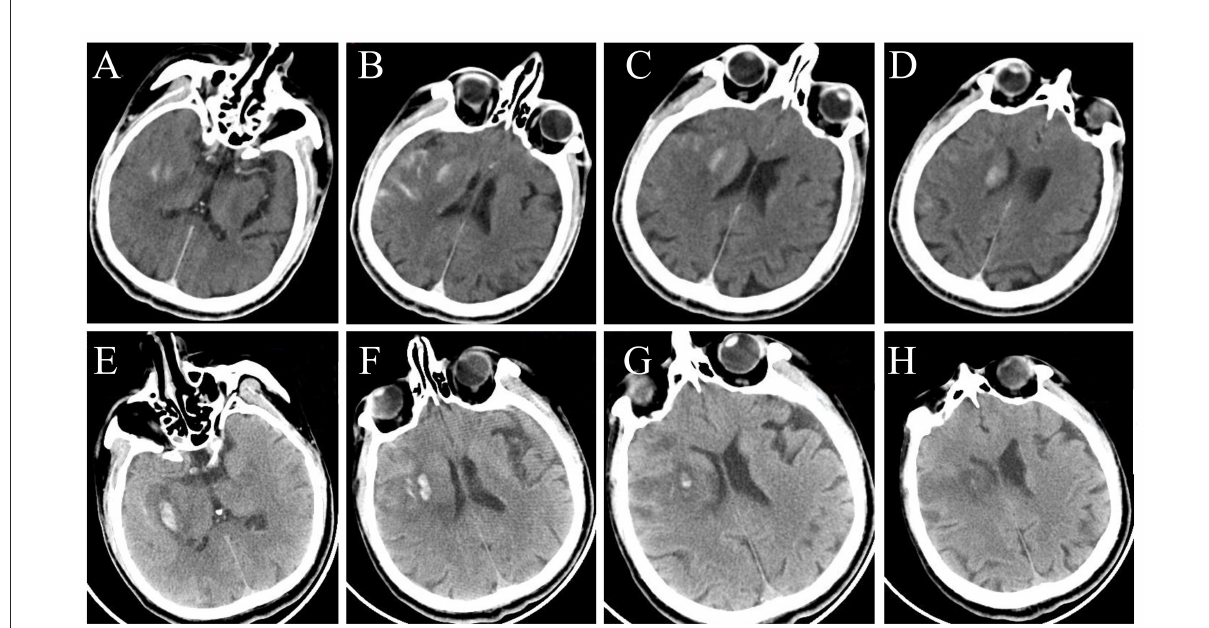
FIGURE1 Representative images of parenchymal hyperdensity immediately after thrombectomy on NCCT (A–D) for Post-ASPECTS assessment; and NCCT images (E–H) at 5 days after thrombectomy showing HT. NCCT, non-contrast computed tomography; Post-ASPECTS, post-thrombectomy ASPECTS; HT, hemorrhagic